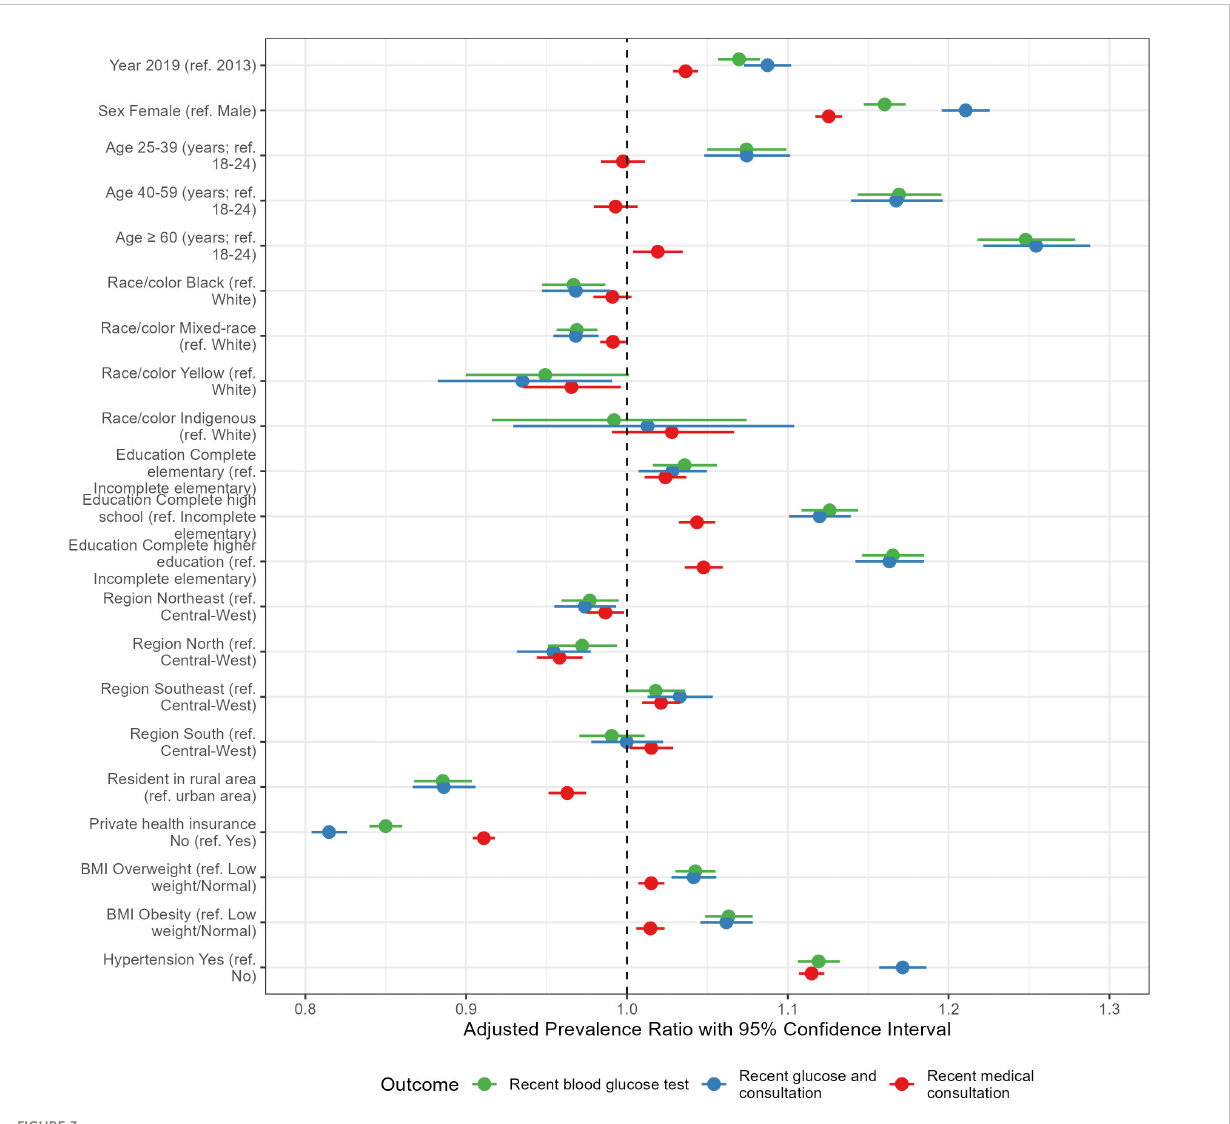
FIGURE 3 Association of survey year and sociodemographic and clinical characteristics with access to a recent glucose test, a recent medical consultation, or both, adjusted for gender, age, education, race/color, geographic macro-region, living in an urban or rural area, having private health insurance, and the year of the survey, as well as BMI and hypertension; the dashed vertical line represents PR = 1.0, meaning no association; PR values on the right side of the dashed line mean factors increasing the prevalence of recent access; otherwise, PR values on the left side of the dashed line mean factors associated with a lower prevalence of recent access. Brazilian National Health Survey, 2013 and 2019. BMI, Body mass